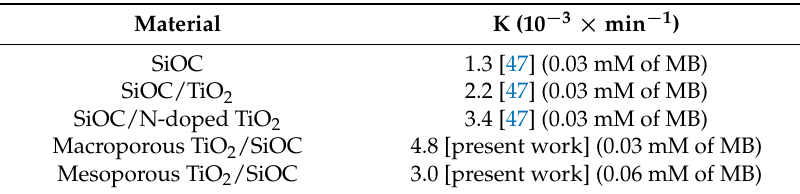
Figure 11. ( a ) UV-vis absorption spectra for 0.06 mM (with 50 mg of mesoporous nanocomposite (inset: photograph revealing the decolorization of MB); ( b ) kinetic analysis of the degradation of MB by mesoporous nanocomposite. Table 1. Comparison of photodegradation constants of various photocatalysts.